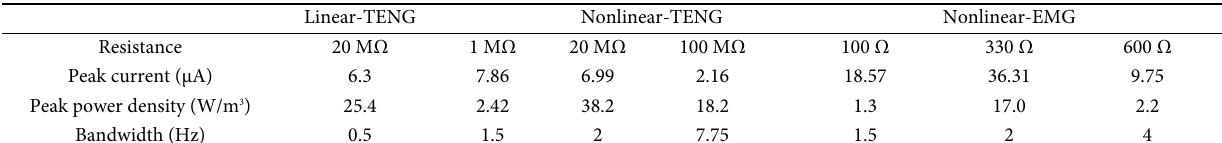
Table 2 Comparisons of peak current, peak power density, and bandwidth Linear-TENG Nonlinear-TENG Nonlinear-EMG Resistance